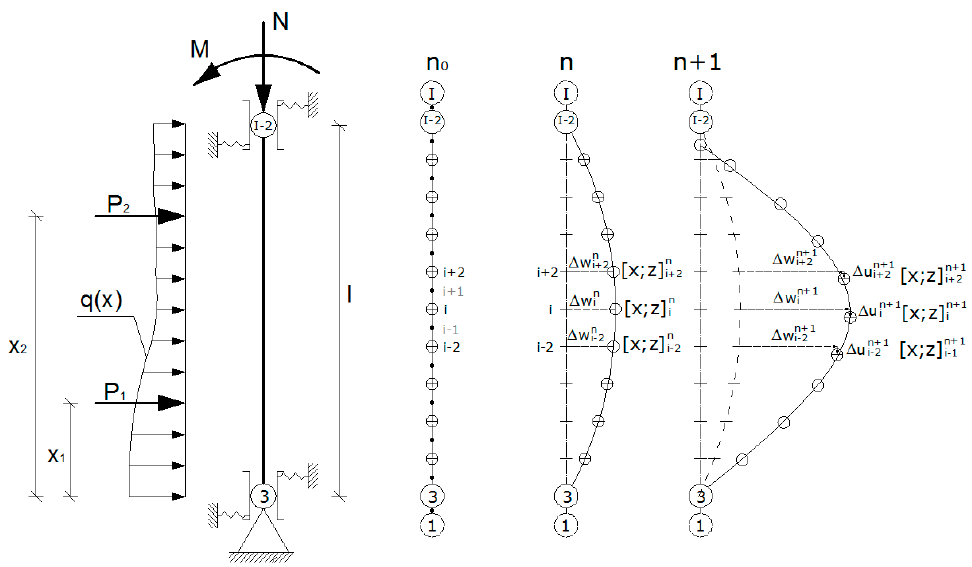
Figure 6. Discretization of the bar’s structural element.